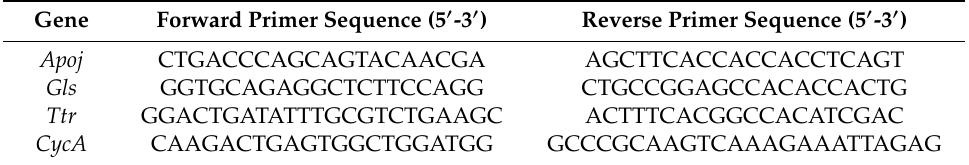
Table 2. Sequences of forward and reverse primers used in real time